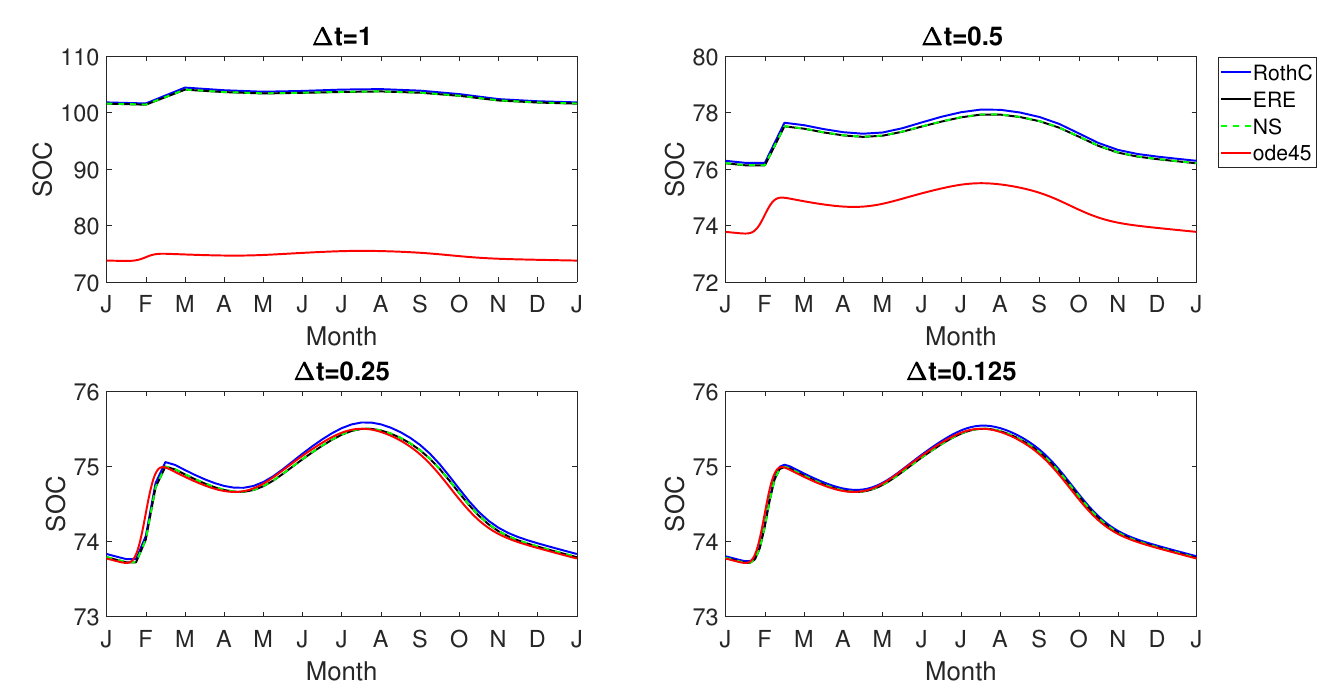
Figure 4. Periodic dynamics of the SOC indicator in a one-period span: convergence of approximated solutions to the reference solution (plotted as a continuous red line) obtained with MATLAB ode45 code, by an increasingly reduction of the stepsize ∆ t .